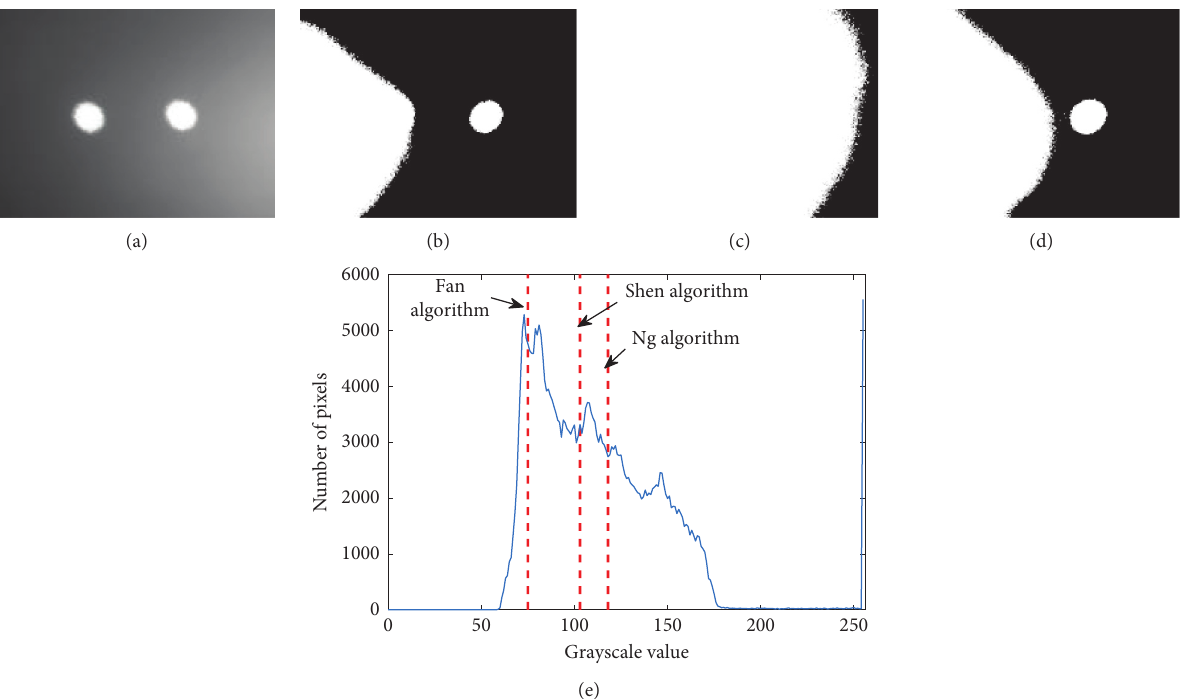
Figure 8: Laser spot segmentation effect under high-intensity light interference: (a) original image, (b) Ng algorithm, (c) Fan algorithm, (d) Shen algorithm, and (e) histogram and each segmentation